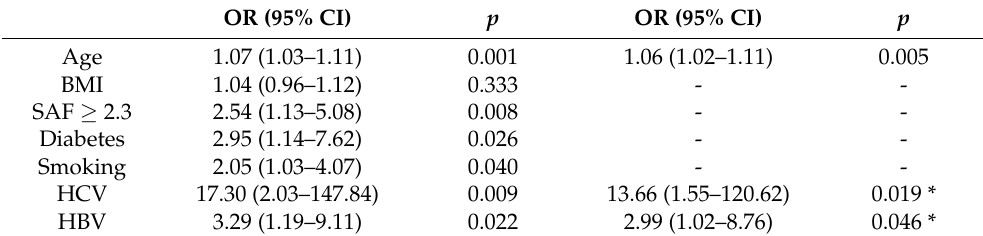
Table 5. Logistic regression model for liver